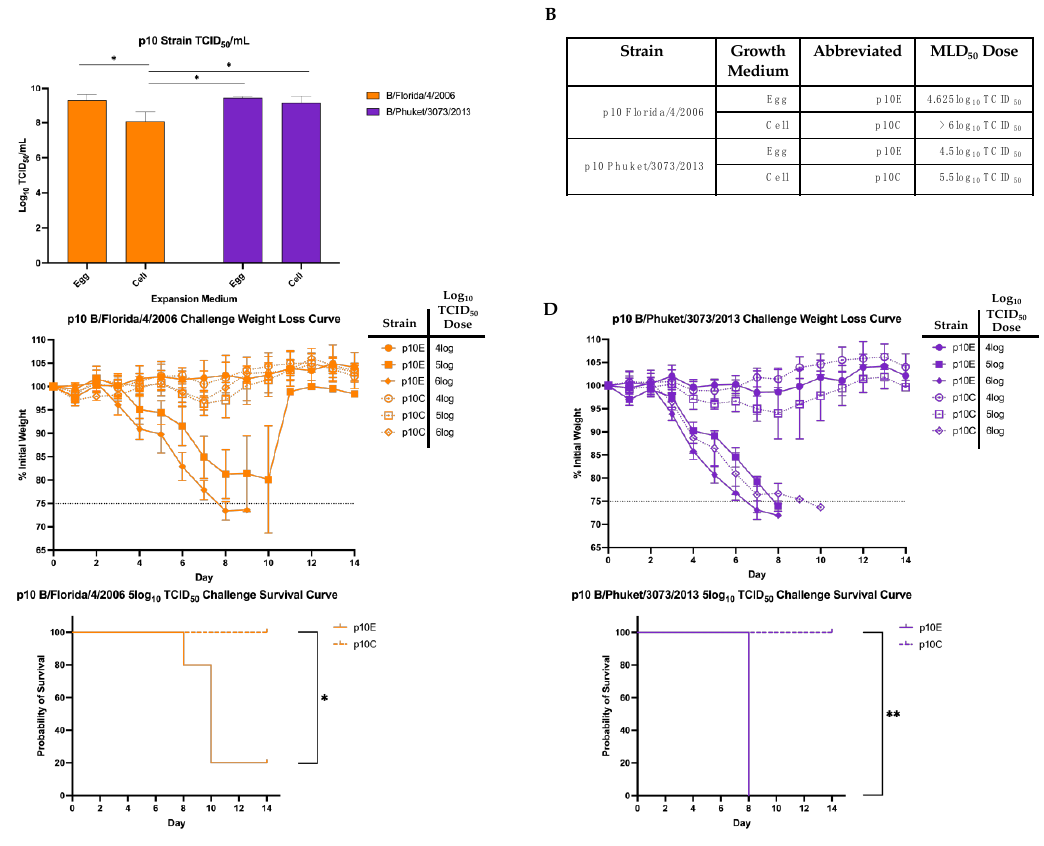
Figure 3. Determination of pathogenicity of maB/Yam in mice. ( A ) TCID 50 /mL titers of both strains after 10 lung-lung passages and expanded in either embryonated eggs (p10E) or MDCK-Ln cell culture (p10C). ( B ) Table breaking down MLD 50 values calculated using the Reed–Meunch method (31) for each virus strain. ( C ) Mice challenged with doses corresponding to logTCID 50 of FL/4/06 p10E or p10C were followed for 14 d.p.i. for weight loss (top) and survival after challenge with 5log TCID 50 units (bottom). A ≥ 25% initial weight lost was used as a threshold for humane sacrifice of the animals. ( D ) Mice challenged with doses corresponding to logTCID 50 of Phu/13 p10E or p10C were followed for 14 d.p.i. for weight loss (top) and survival after challenge with 5log TCID 50 units (bottom). A ≥ 25% initial weight lost was used as a threshold for humane sacrifice of the animals. Statistical differences in TCID 50 /mL titers were calculated using unpaired t-tests, while statistical significance between group survival was calculated through log-rank Mantel–Cox test. Statistical analysis was performed in GraphPad Prism 9.0 (* p < 0.05, ** p <